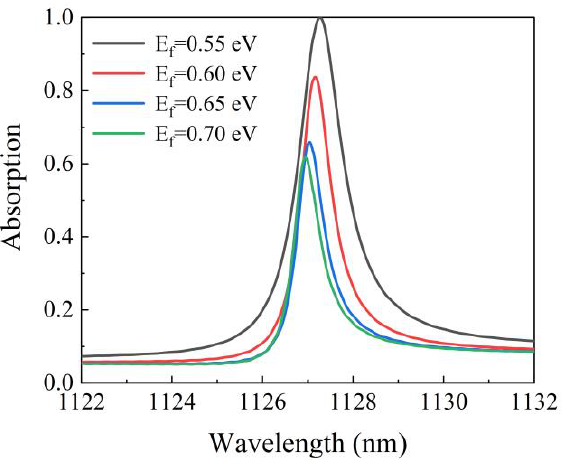
Figure 5. The changes in the absorption spectrum of the structure with the increase in Fermi energy, and the other parameters are kept constant.